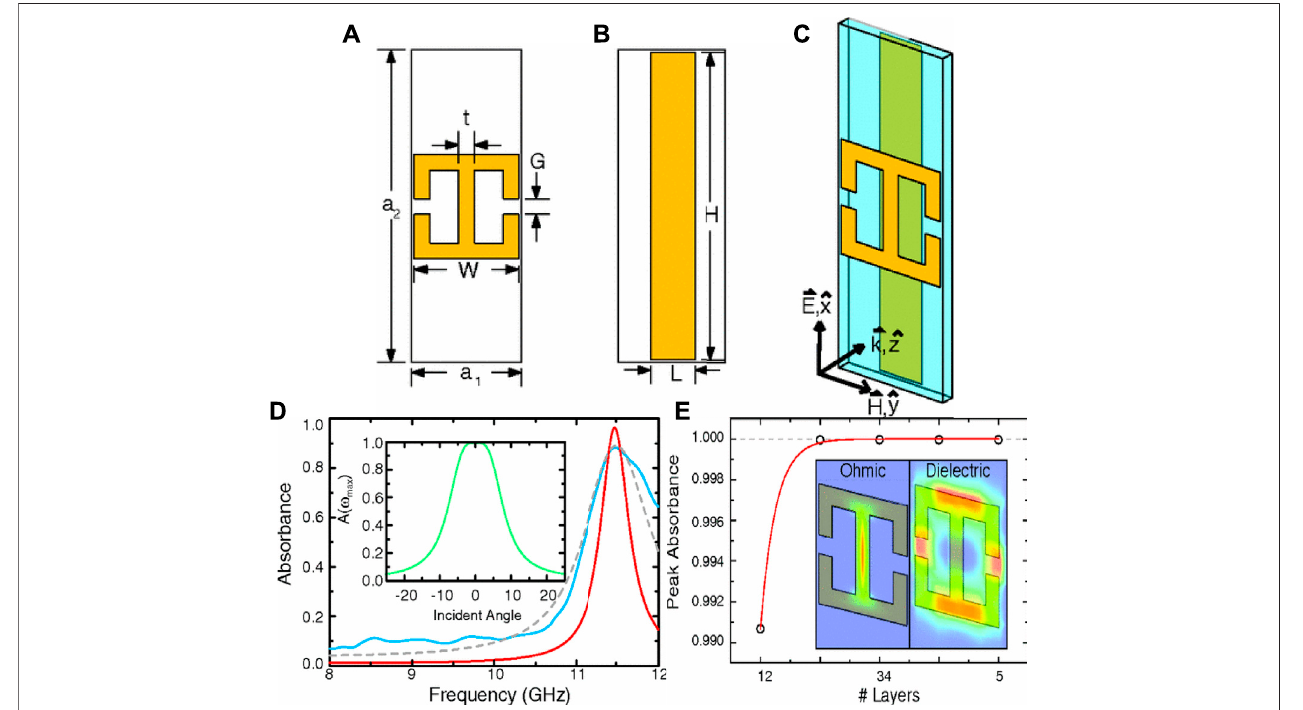
FIGURE 8 | (A) Schematic absorber structure, (B) cut wire, (C) unit cell displaying the direction of wave propagation. (D) Absorption spectra with respect to frequencyandincidentangle. (E) SimulatedA( ω )withincreasingMMlayers;Insetsshowthesimulatedlossesatresonance:Ohmicloss(surface)isshownintheleftinset panel, and the dielectric (volume) loss is on the right. Adapted with permission from Ref. [14]. Copyright (2008) American Physical Society.